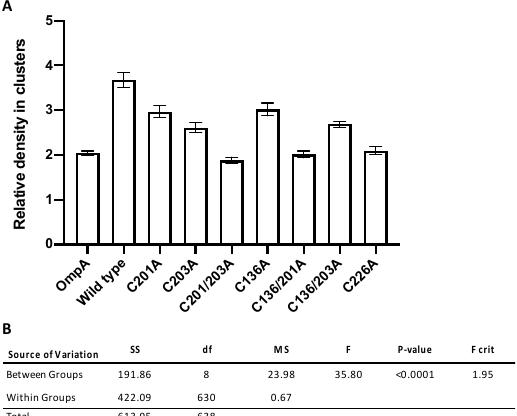
Figure 4. ( A ) Graph displaying the relative cluster densities of OmpA, wild-type rMOMP, and rMOMP cysteine mutants. dSTORM localisation data were analysed with ClusDoC software before the mean and standard error were calculated for each sample (Table 1). All data were collected and processed under the same conditions. The relative density in clusters is provided as a standardised arbitrary unit and error bars indicate the standard error. ( B ) One-way ANOVA statistical analysis of dSTORM localisation data. The null hypothesis that there is no statistically significant di ff erence between groups can be rejected as p < 0.05 and the F critical value of 1.95 is less than F at 35.80. SS, sum-of-squares; df, degrees of freedom; and MS, mean squares.